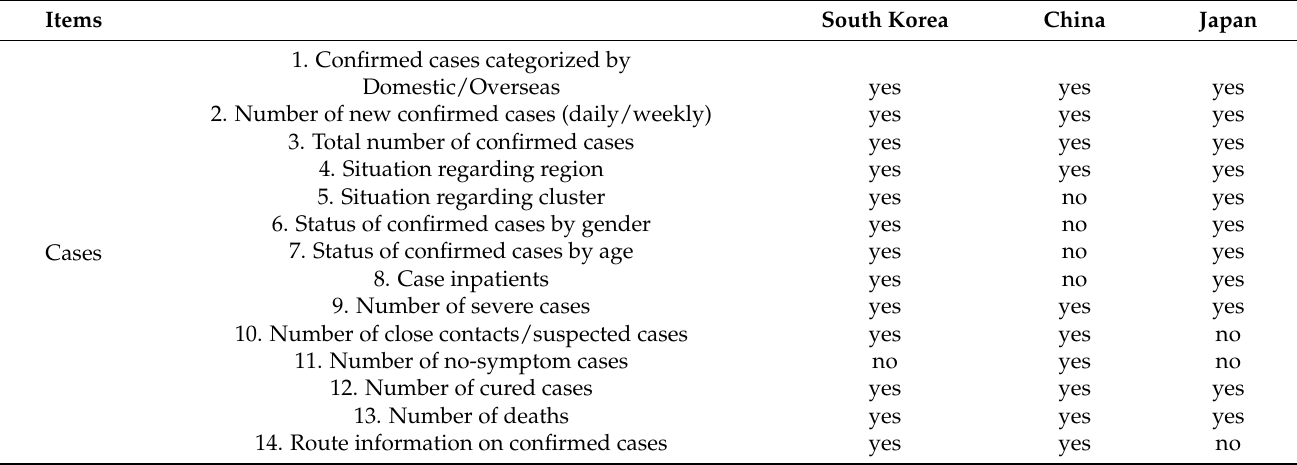
Table 1. Content comparison for “cases” on the COVID-19 dashboard in South Korea, China, and Japan. Items